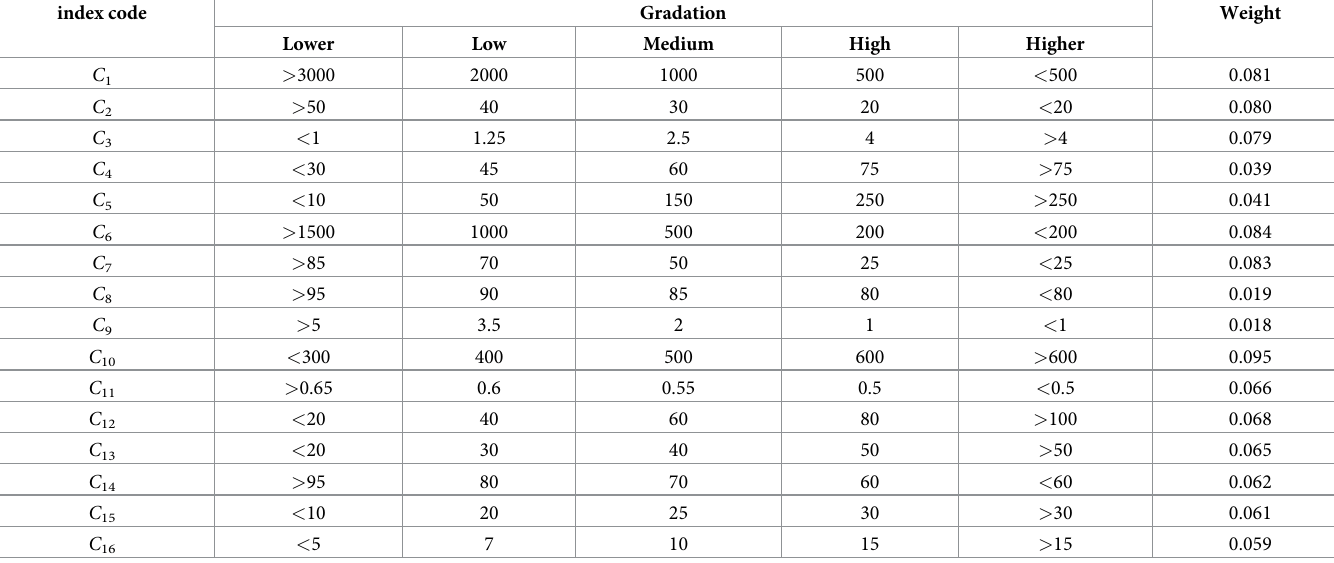
Table 6. Index weights and corresponding evaluation standard value